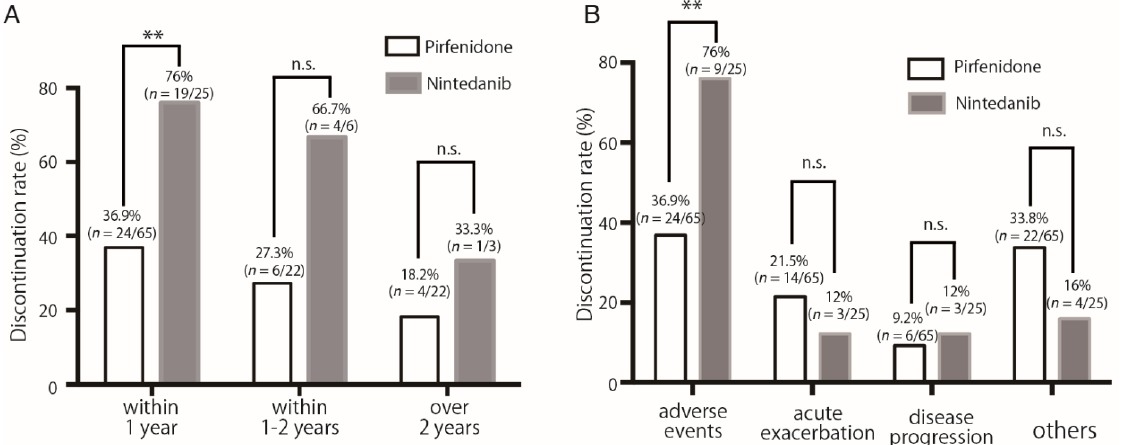
Figure 3. Comparison of ( A ) discontinuation rates due to adverse events over time and ( B ) discontinuation profiles within a year in the pirfenidone and nintedanib treatment. ** p < 0.01.